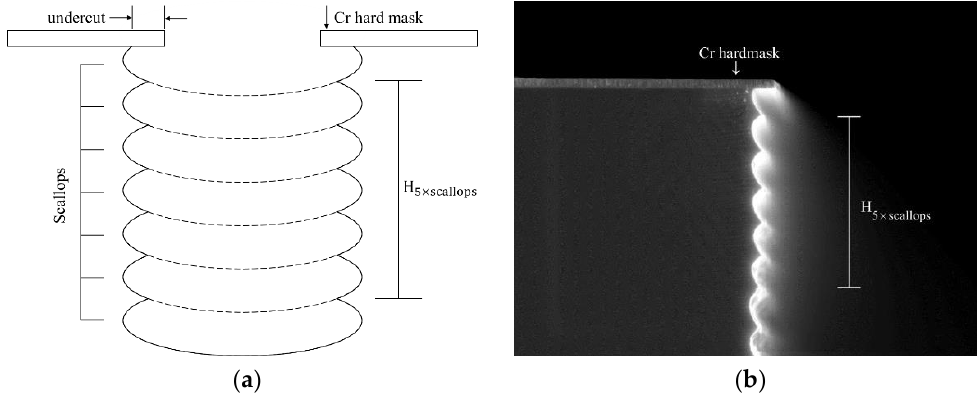
Figure 2. Measuring method of the initial etch rate: ( a ) schematic; ( b ) SEM image in cross-section of a real etched grating. The height of 5 scallops is used to measure the initial etch rate.